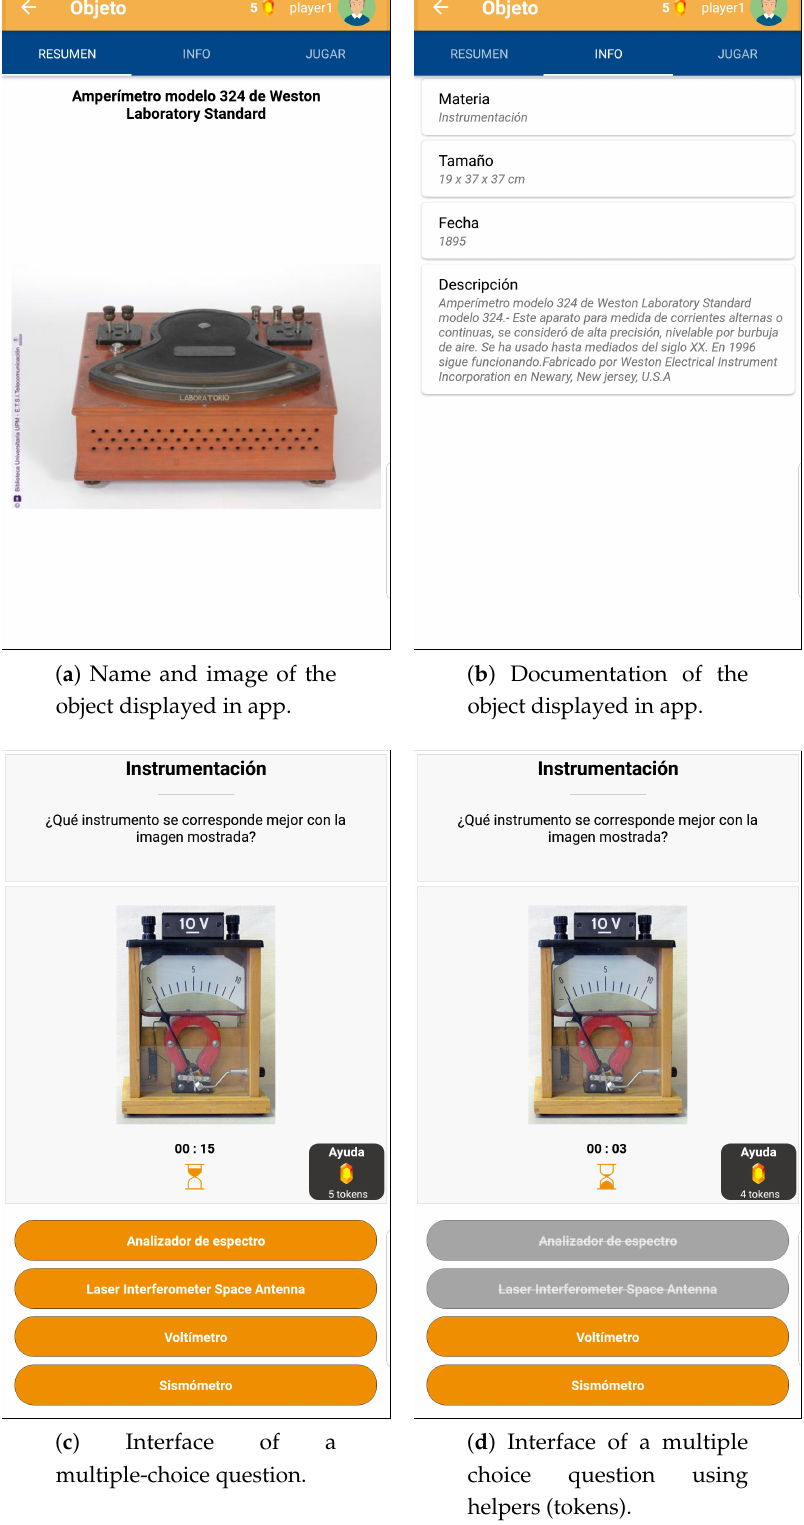
Figure 5. Screenshots of the smartphone